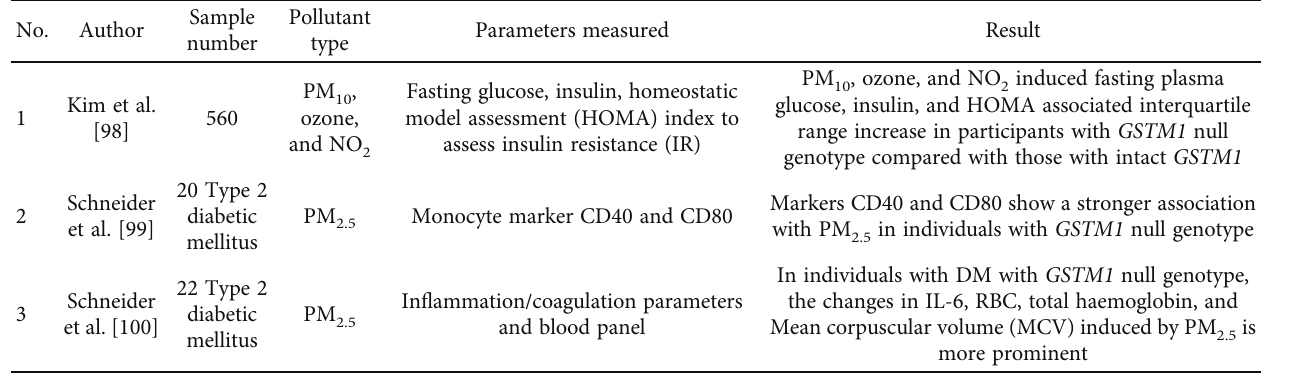
Table 4: Studies about GSTM1 null genotype e ff ect on air pollutant especially PM association with diabetes mellitus (DM).